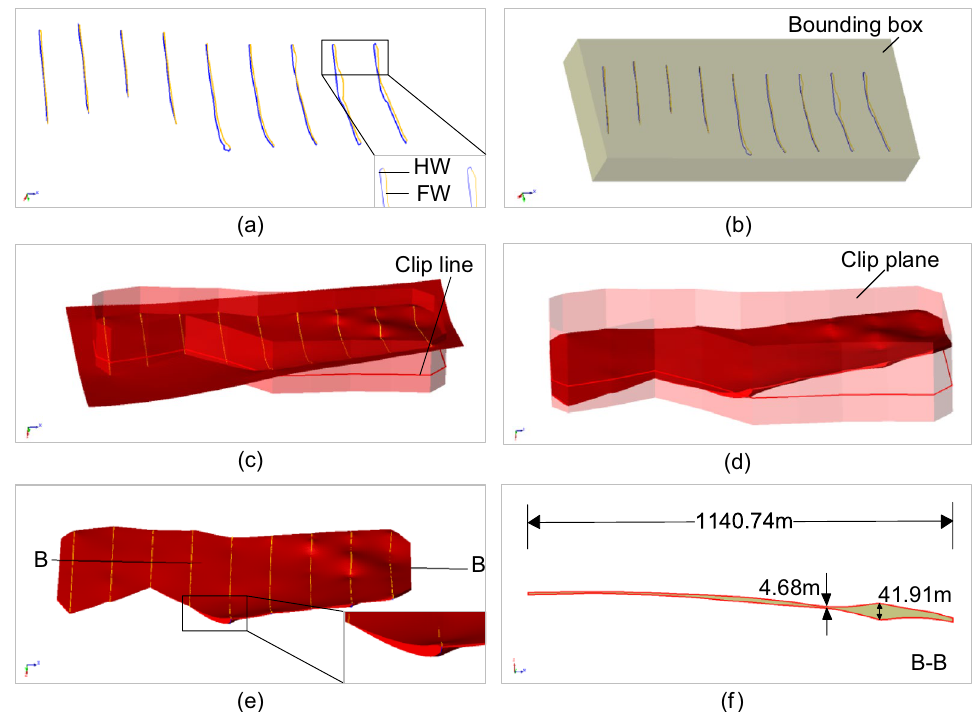
Figure 9. Implicit modeling of a narrow vein orebody model. ( a ) Contour polyline data; ( b ) rectangle bounding box; ( c ) initial model; ( d ) clipped model; ( e ) final model; ( f ) slicer view.